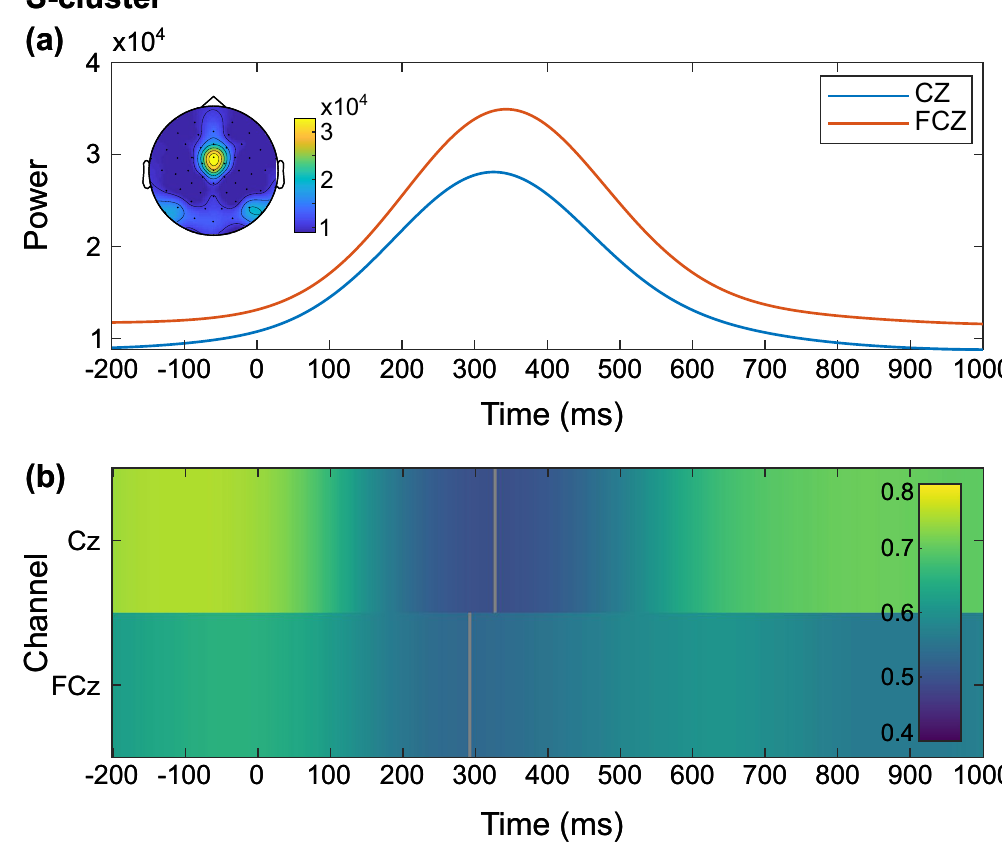
Figure 3. Time course of total theta power and correlation between resting and inhibition-related theta power in the S-cluster. ( a ) Participants’ grand average showing the course of inhibition-related total theta power in the frequency band of 5 Hz in the S-cluster from 200 ms before stimulus onset to 1000 ms after the stimulus onset at electrodes Cz (blue) and FCz (orange). The scalp topography corresponds to the time–frequency window of 344 ms and 5 Hz. ( b ) Correlation between resting-state theta activity and inhibition-related total theta activity in the S-cluster from 200 ms before stimulus onset to 1000 ms after stimulus onset for the electrodes Cz and FCz. Only significant correlations with p ≤ .05 after a channel-by-channel correction with the false discovery rate (FDR) method are shown. The grey areas were not significant after FDR correction. The correlation coefficient r is indicated by